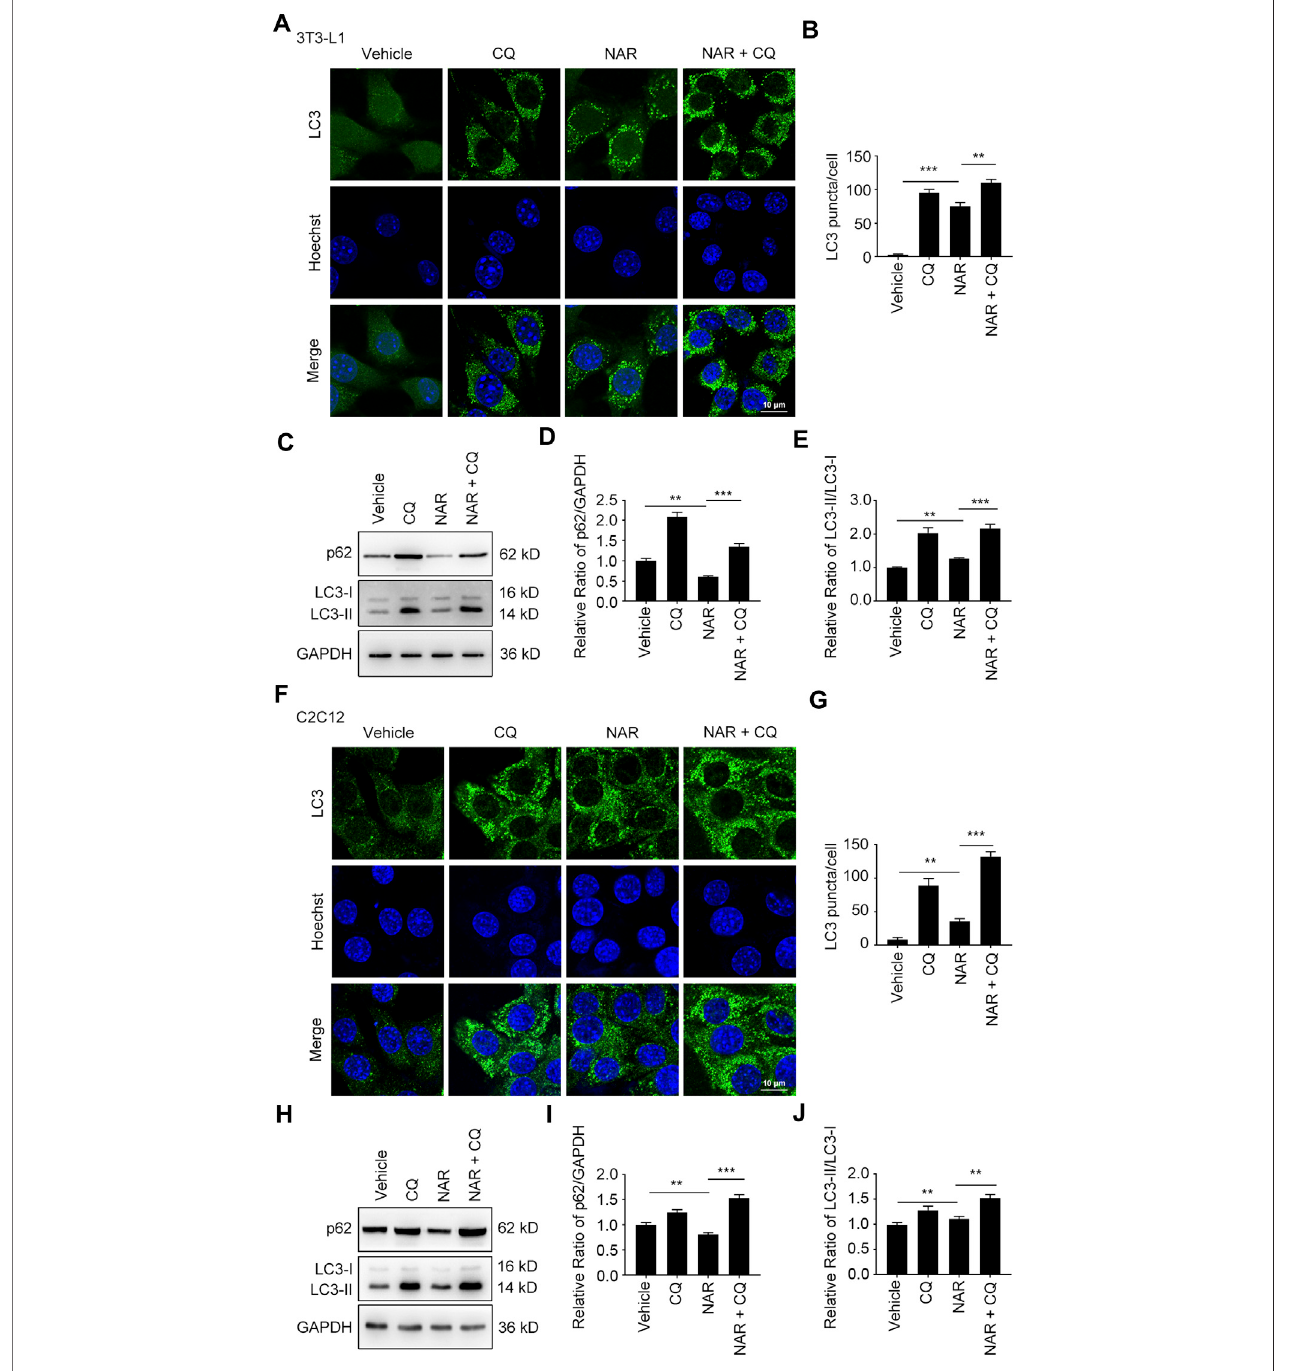
FIGURE 6 | NAR promotes the initiation of autophagy in the autophagic fl ux of 3T3-L1 preadipocytes and C2C12 myoblasts. LC3 in 3T3-L1 preadipocytes (A,B) andC2C12myoblasts (F,G) aftertreatmentofNARorincombinationwithCQweredetectedbyimmuno fl uorescence(green),andpicturedbyconfocalmicroscopy(the objective ampli fi cation 63 × ). The expression of p62 and LC3 in 3T3-L1 preadipocytes (C – E) and C2C12 myoblasts (H – J) was detected by Western blotting. Bars represent 10 μ M. All values were expressed as the mean ± SD from three or more independentexperiments. *** p < 0.001; ** p < 0.01; * p < 0.05 vs. untreated cells or as indicated. Abbreviation: NAR, naringenin; CQ, chloroquine.